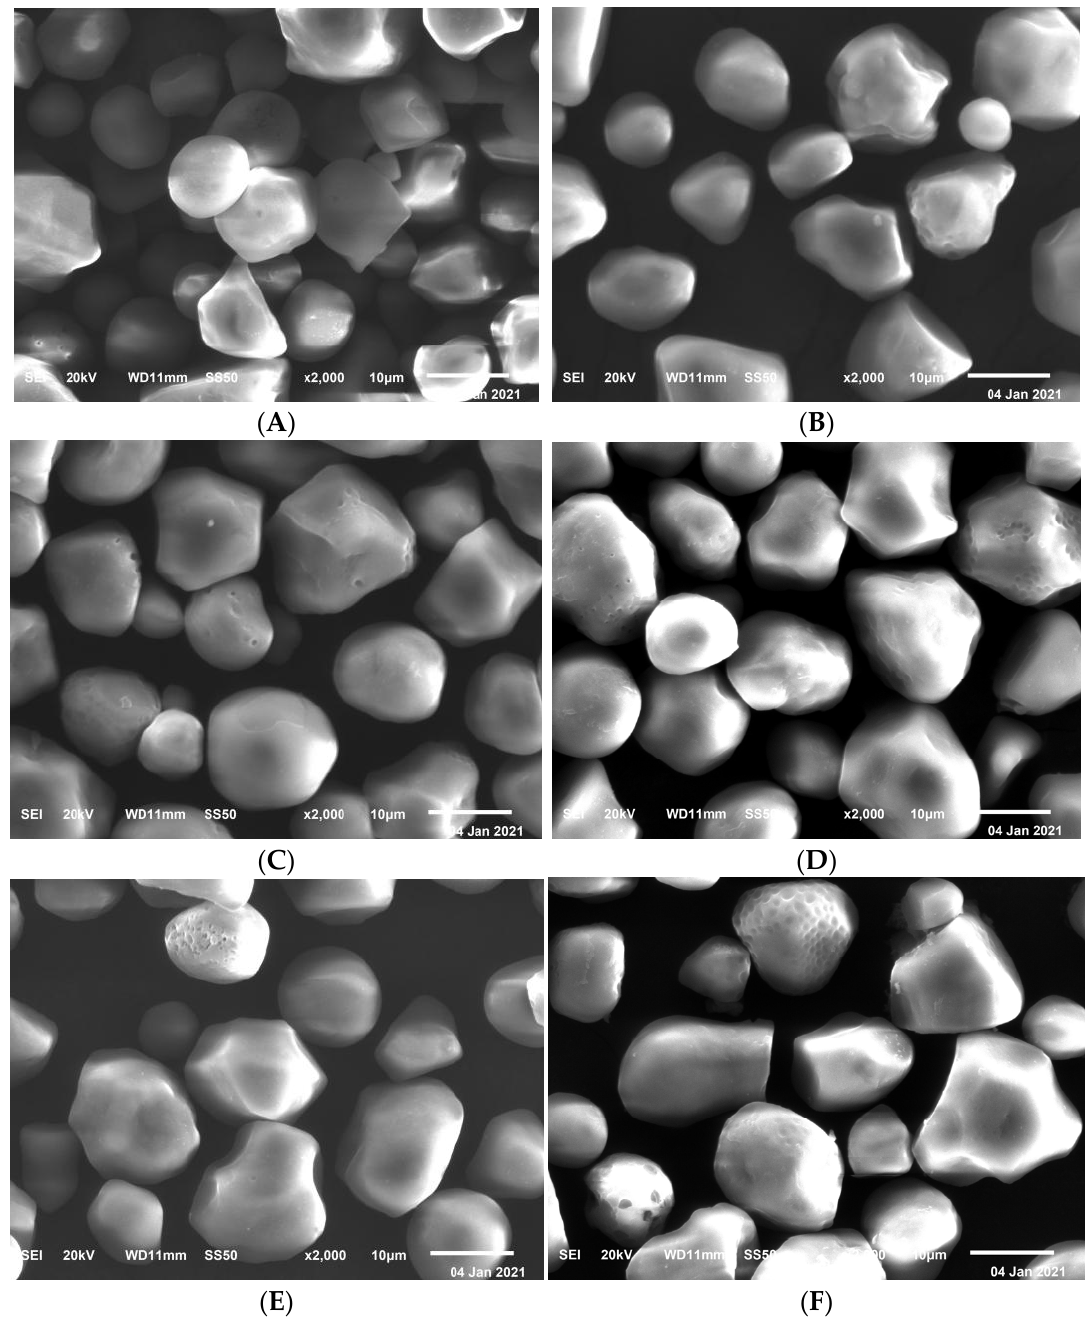
Figure 3. Scanning electron micrographs (2000×, bar as 10 μ m) of native starch ( A ) and γ -HPS at MS = 0.008 ( B ), MS = 0.017 ( C ), MS = 0.053 ( D ), MS = 0.106( E ), and MS = 0.178 ( F ).